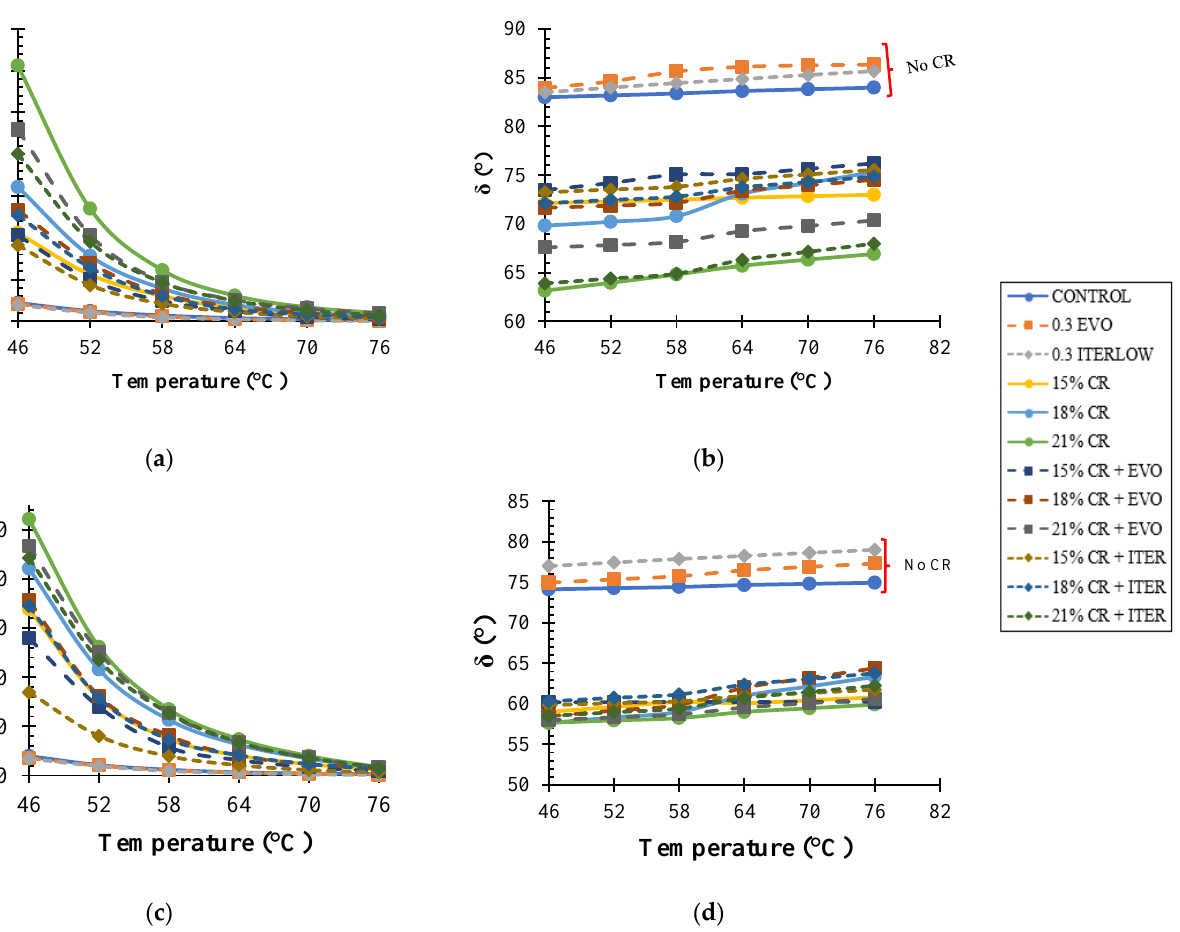
Figure 9. ( a ) G * vs. temperature for unaged sample, ( b ) δ vs. temperature for unaged sample, ( c ) G * vs. temperature for RTFO aged sample, ( d ) δ vs. temperature for RTFO aged sample.